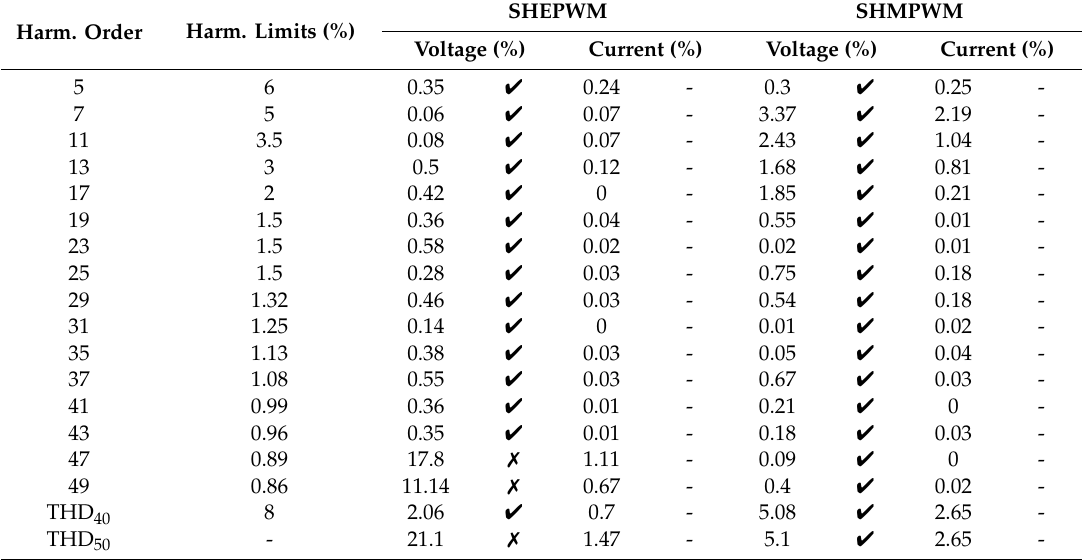
Table 4. Simulation results of SHEPWM and SHMPWM at the converter side. Harm. Order